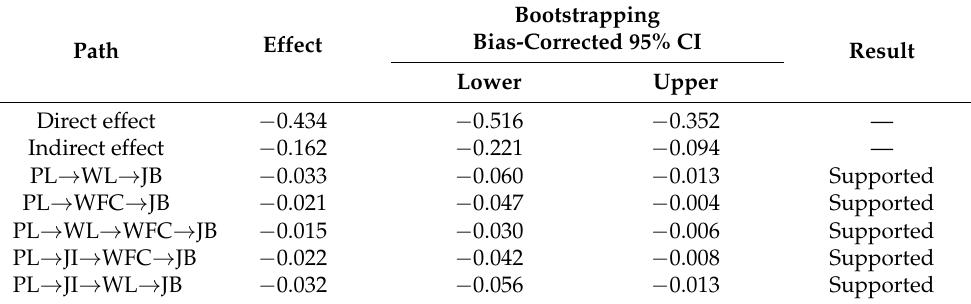
Table 7. Analysis of mediation